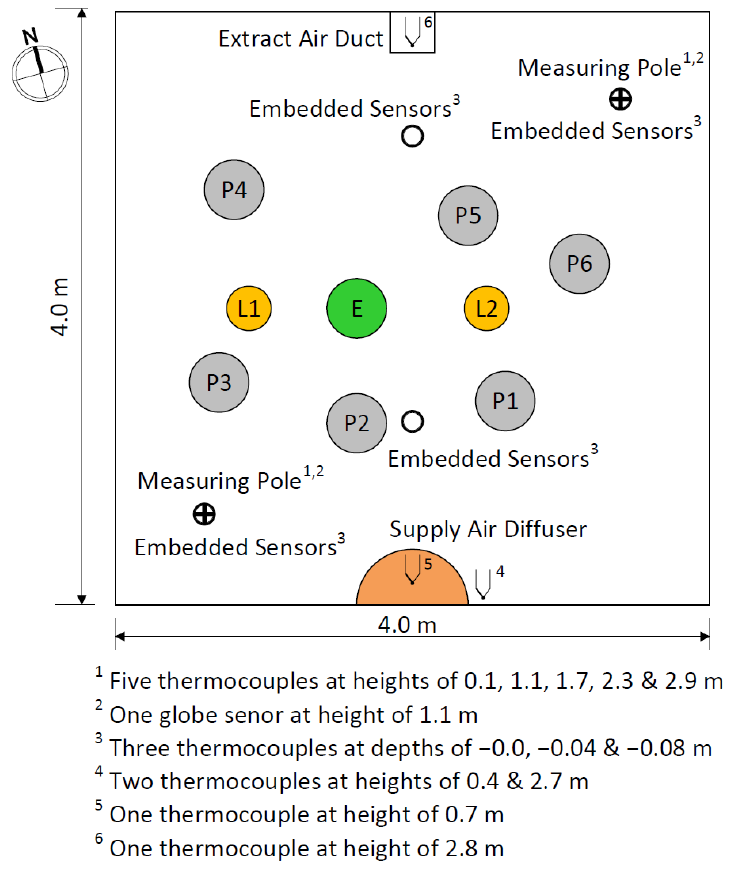
Figure 4. Floor plan of the test room with measurement points and internal heat sources (people: grey, lighting: yellow, equipment: green).